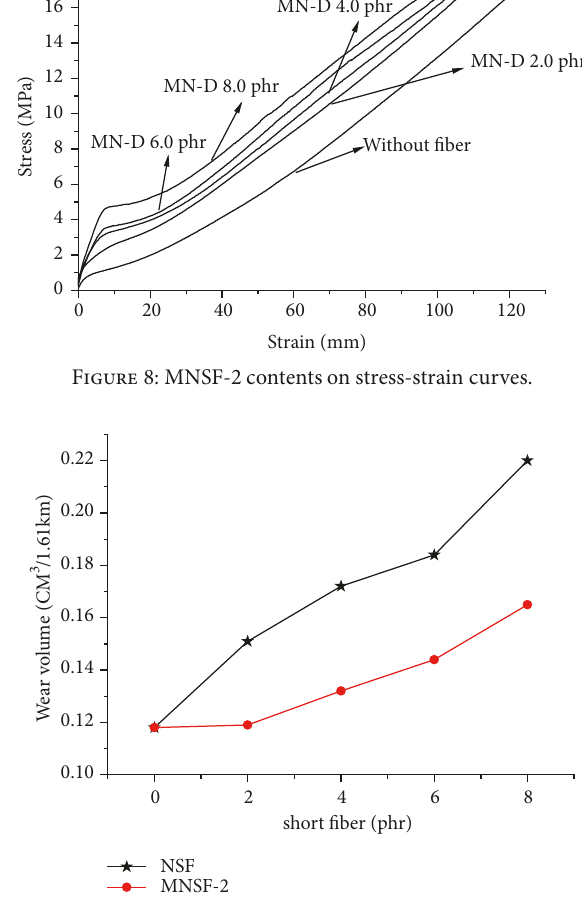
Figure 9: Short fiber contents on wear volume of tread